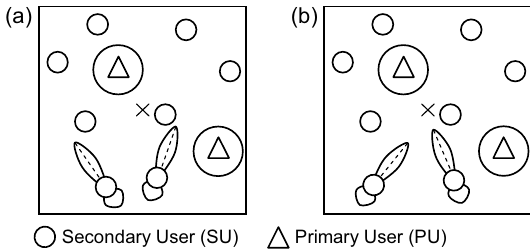
Figure 5. Illustration of two beamforming schemes used to evaluate the connectivity of CRAHNs: ( a ) randomized beamforming; ( b ) center-directed